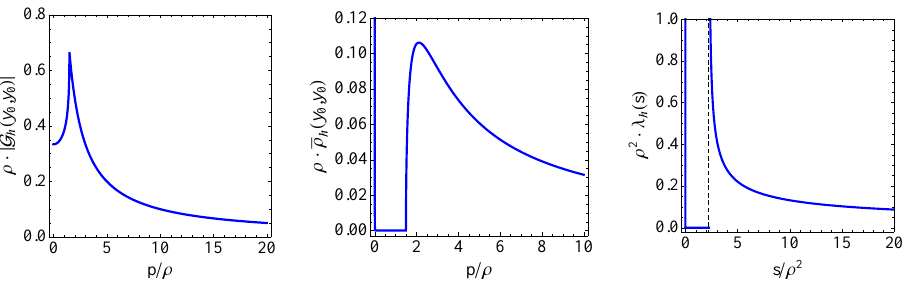
Figure 2. Plots of the Green’s function |G h ( y 0 ,y 0 ; p ) | (left panel), spectral function ¯ ρ h ( y 0 ,y 0 ; p ) (middle panel), and density of states λ h ( s ) (right panel), as a function of the momentum, for a continuous graviton, cf. Eqs. (19) and (21). The dashed vertical line in the right panel corresponds to s = m 2 have used ¯ ϵ = 0 . 1 , A 1 = 23 and assumed time-like momenta p 2 > 0 .